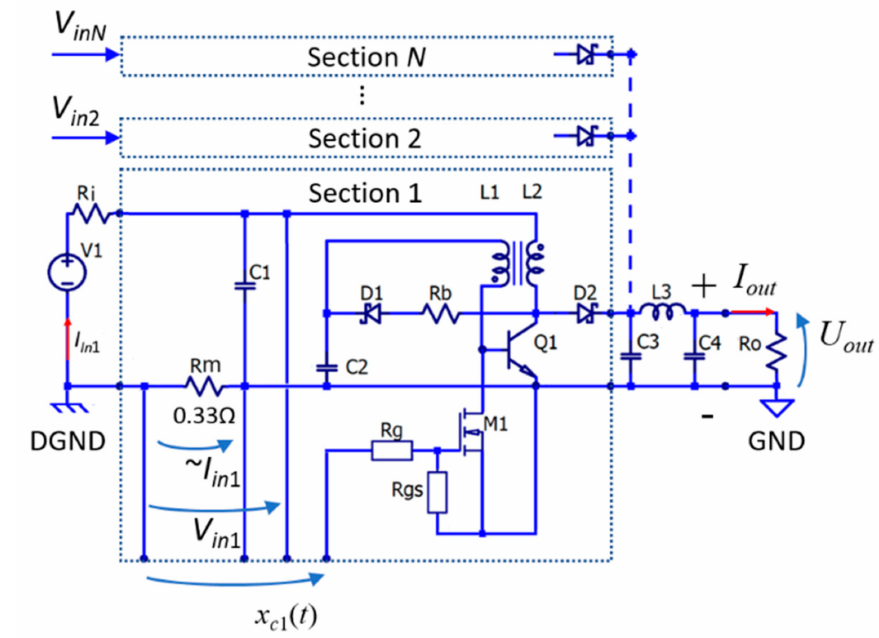
Figure 7. Electric diagram with simple boost converter dedicated to each TE string.